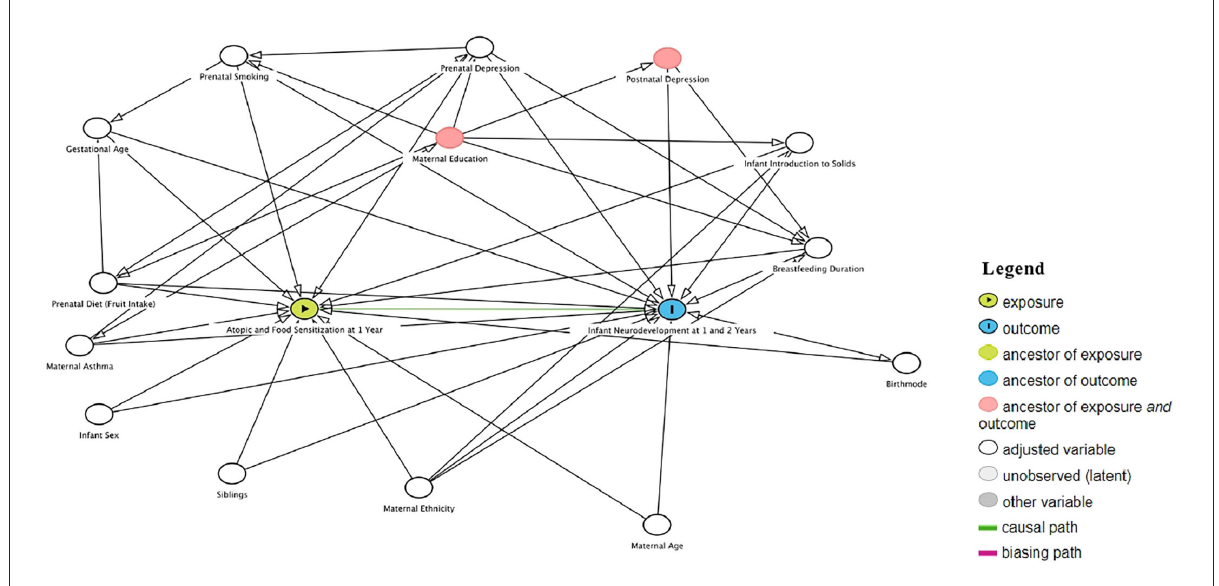
FIGURE1 Direct acyclic graph (DAG) representing exposure, covariate, and outcome direct associations to select pontiential confounding factor.